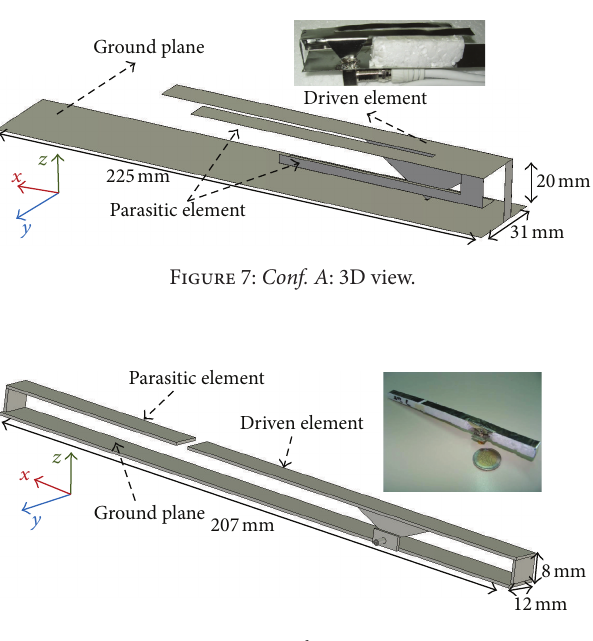
Figure 8: Conf. B : 3D view.